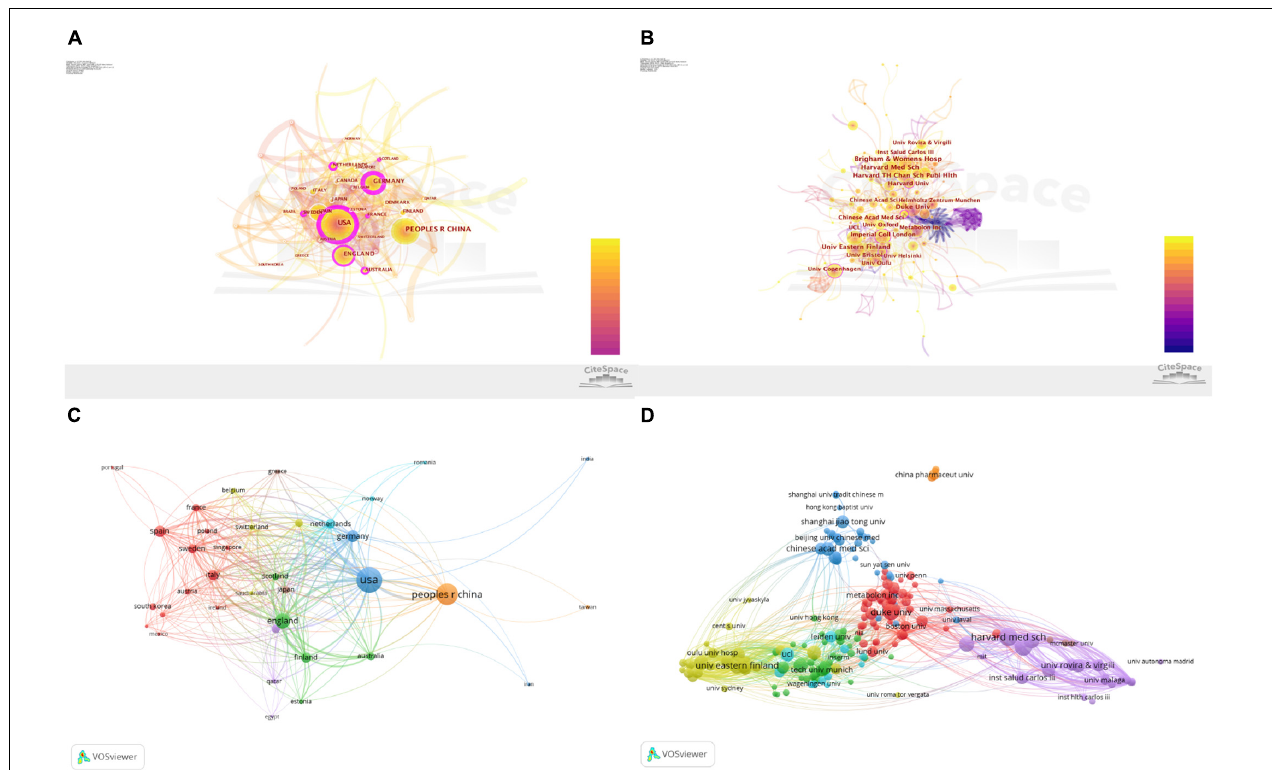
FIGURE 2 | Visualisation map of the countries and institutions involved in coronary artery disease and metabolome research. Collaboration among countries/regions (A) and institutions (B) using CiteSpace. The node represents the country/region or institute. The thickness of the lines indicates the strength of the relationship. The betweenness centrality of the nodes with the purple circle is > 0.1. Collaboration network of countries/regions (C) and institutes (D) using VOSviewer. Different colours mean clusters of an intimate relationship.